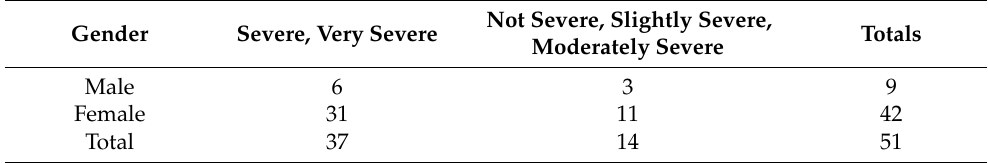
Table 1. Gender distribution of survey respondents and their perceptions on idling.